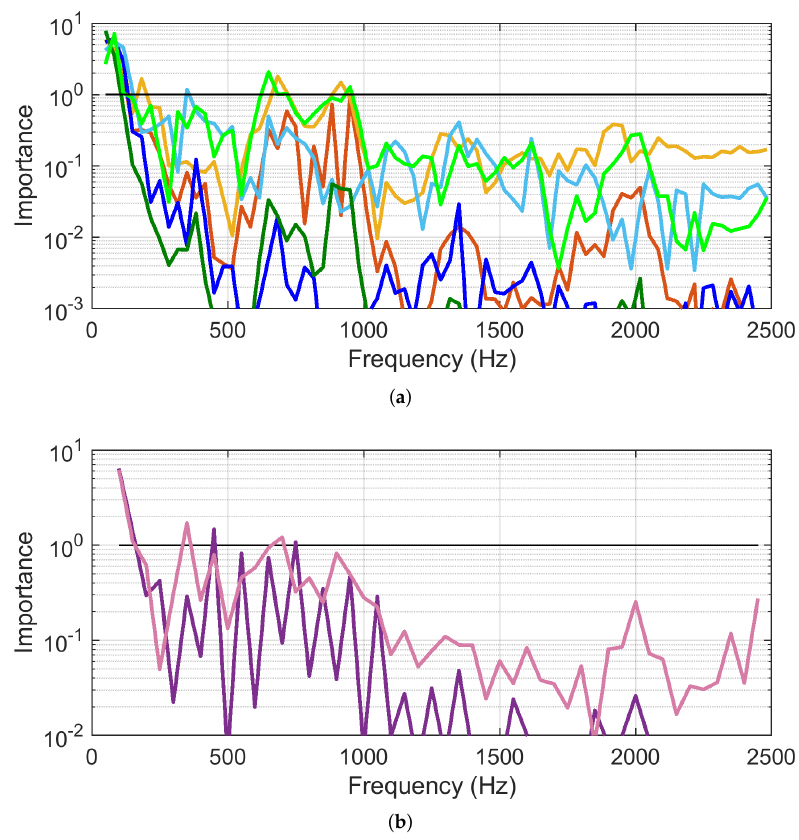
Figure 15. PLSR VIP scores for ( a ) 16.7Hz system representation (CH tra-brk brown dark and light, D tra-brk blue dark, and combined CH and D green dark and light light, ( b ) combined 16.7Hz and 50Hz system representation (Switzerland, Germany, and France); dark and light refer to P h and I h